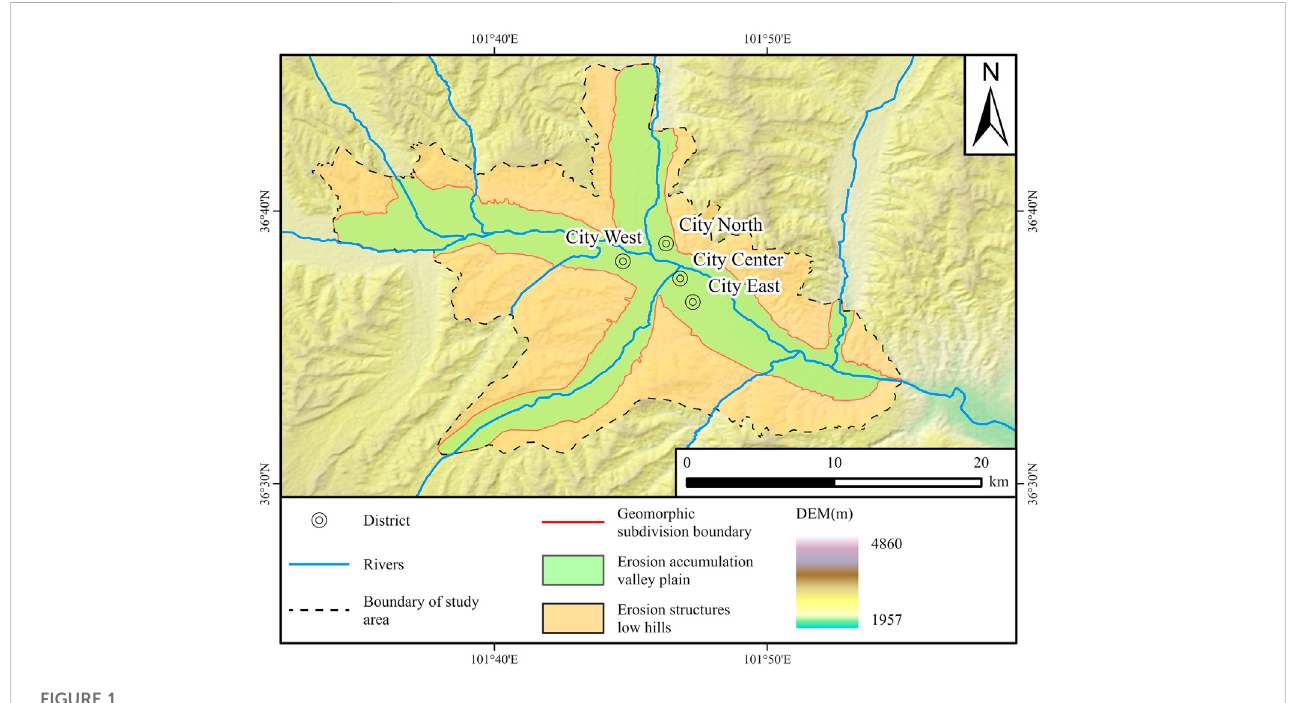
FIGURE 1 Outline of the geomorphic types in the study area.